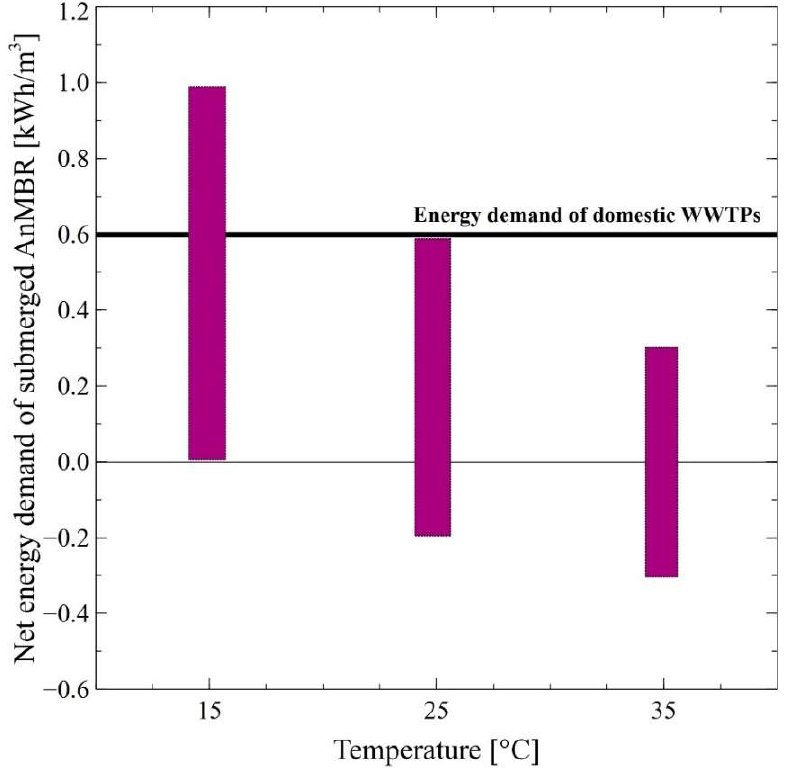
Figure 8. The net energy demand of submerged AnMBRs is used for the treatment of domestic wastewaters. Based on [140].